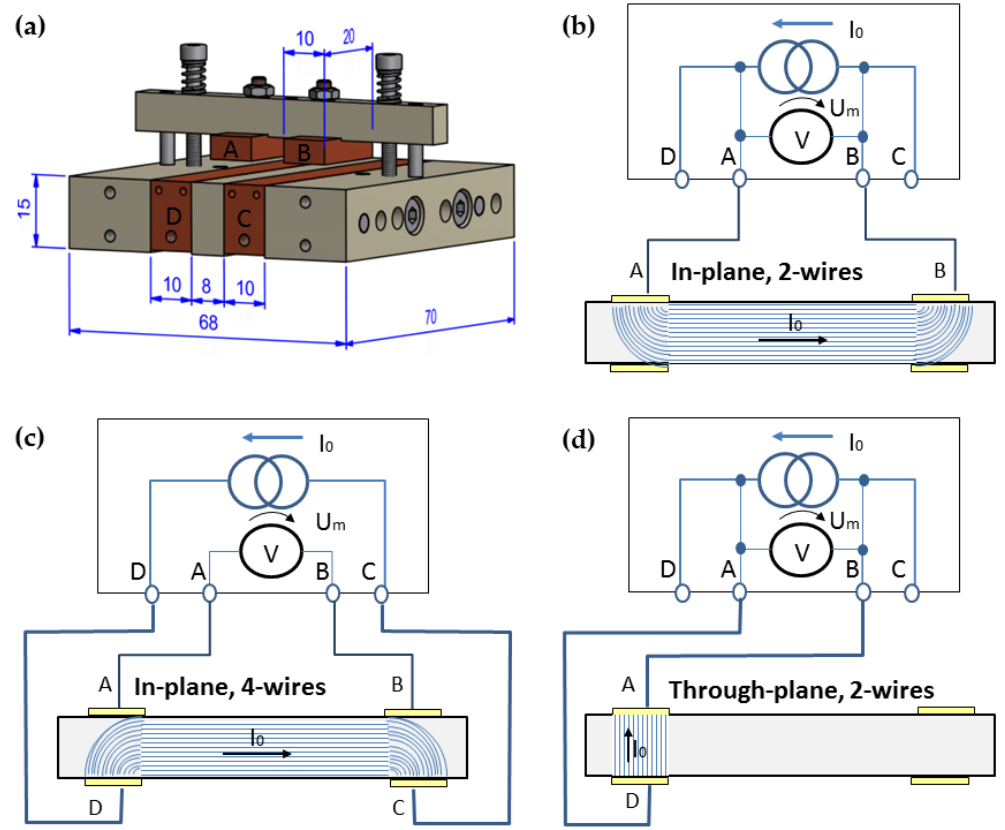
Figure 1. Device temperable resistance measurement (TWM1) for electrical volume resistance measurements in two directions, ( a ) schema, principle of ( b ) in-plane measurement with 2 wires, ( c ) or 4 wires, and ( d ) through-plane measurement.